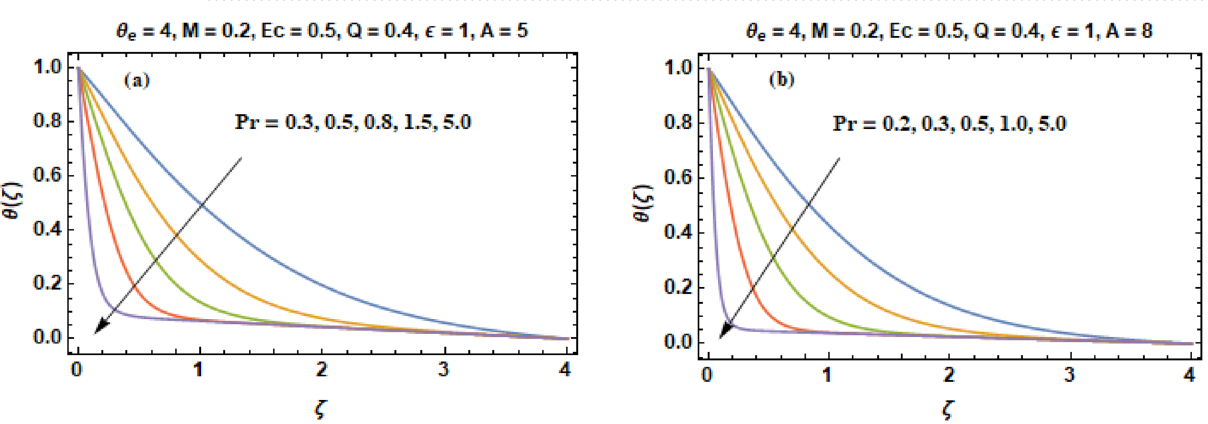
Figure 3. ( a , b ) Temperature curves (θ) versus Pr when ( a ) A = 5 and ( b ) A = 8